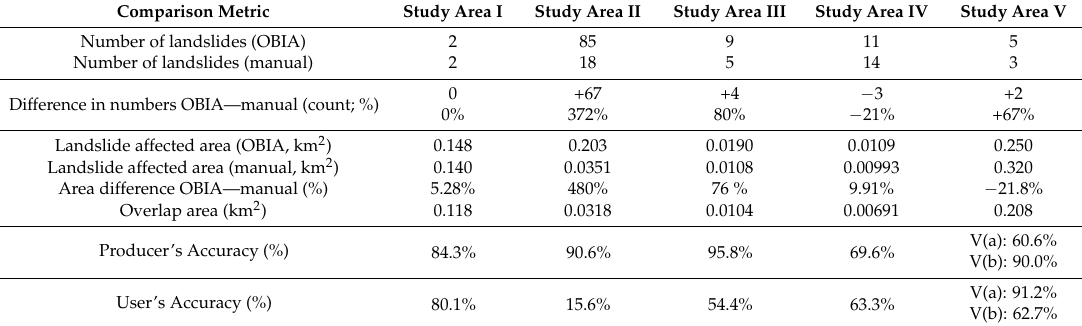
Table 7. Comparison of OBIA mapping results and manual mapping results per study area.